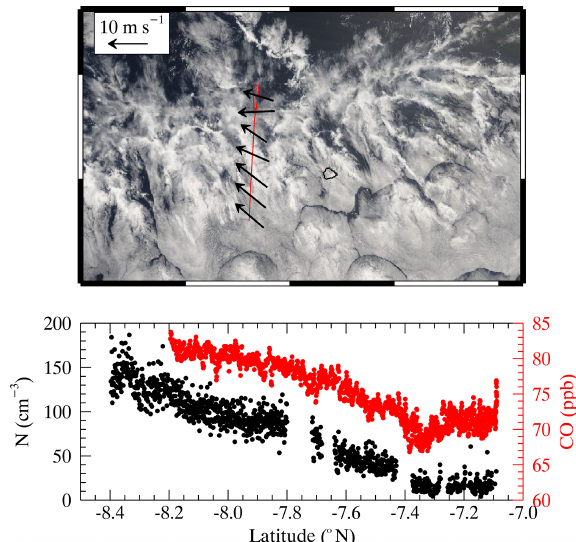
Figure 14. PCASP number concentration and carbon monoxide data on 6 September 2017 (10:06 to 10:34UTC) measured on flight C053. The data are to the west of Ascension Island and in the sur- face mixed layer (314m altitude). The run crossed the boundary between open cells to the north and more stratiform cloud to the south. The flight track and measured wind vectors are overlaid on a MODIS Terra image valid at 11:27UTC. The MODIS image was obtained from NASA